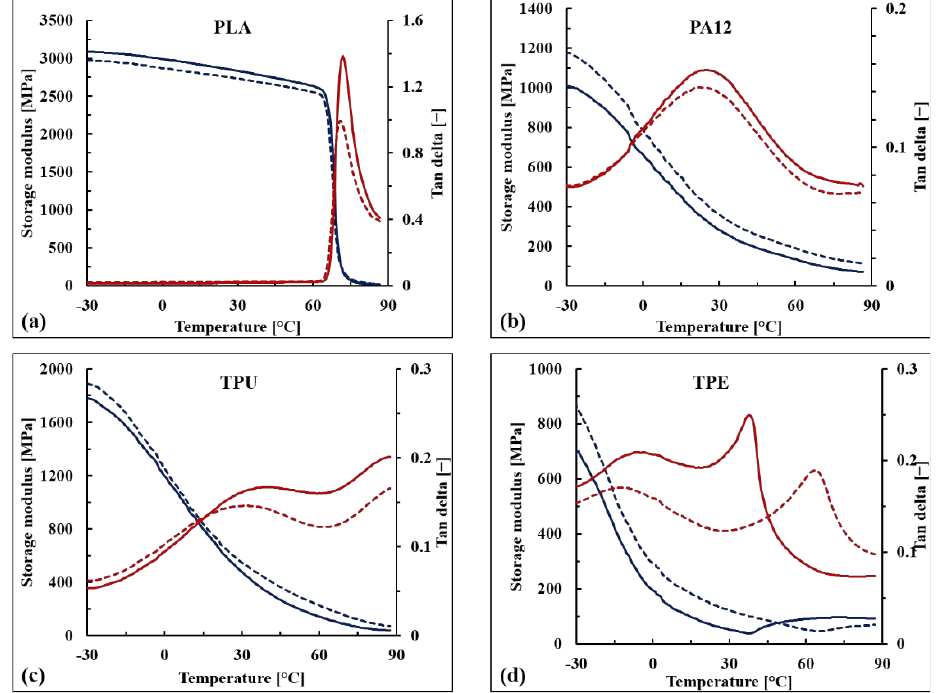
Figure 10. Dynamic mechanical analysis (DMA) of PLA ( a ), PA12 ( b ), TPU ( c ), and TPE ( d ) samples. Blue and red curves refer to the storage modulus (E’) and the damping factor (tan δ), respectively; meanwhile, the solid and dotted lines indicate the properties of the neat polymer and the corresponding WB-based composite, respectively. Table 6. Dynamic mechanical analysis (DMA) of WB-based samples.